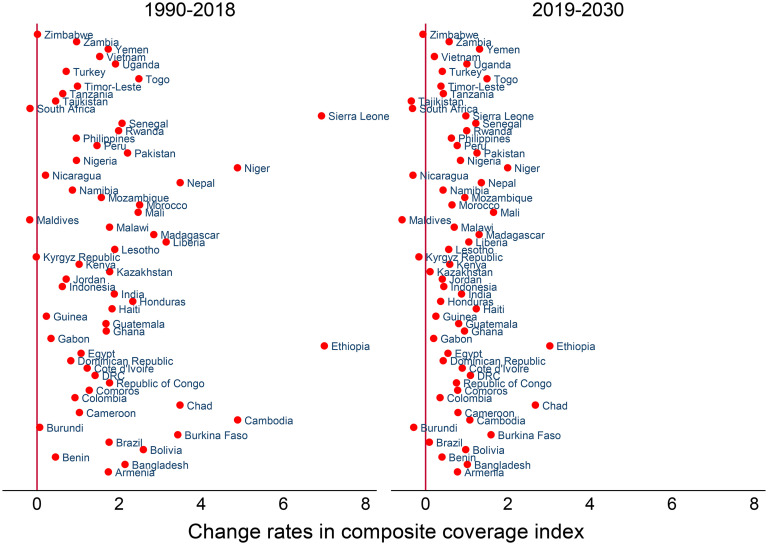
Average Annual Rate of Changea in Composite Coverage Index in Low- and Middle-Income Countriesa Annual rate of change is calculated as: ln[(rate in latest year/rate in earliest year)]/(latest year − earliest year), with positive values located on the right side of the diagonal line at 0 (in X-axis) denoting an increasing rate, while negative values located on the left side of the diagonal line at 0 (in X-axis) denoting a decreasing rate.